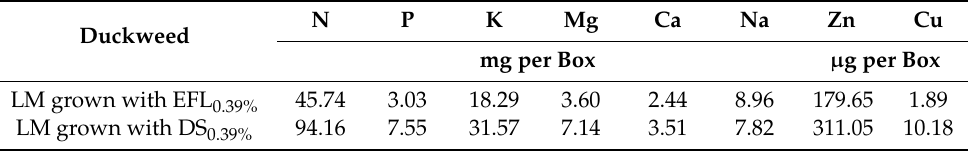
Table 7. Nutrient uptake by Lemna minuta